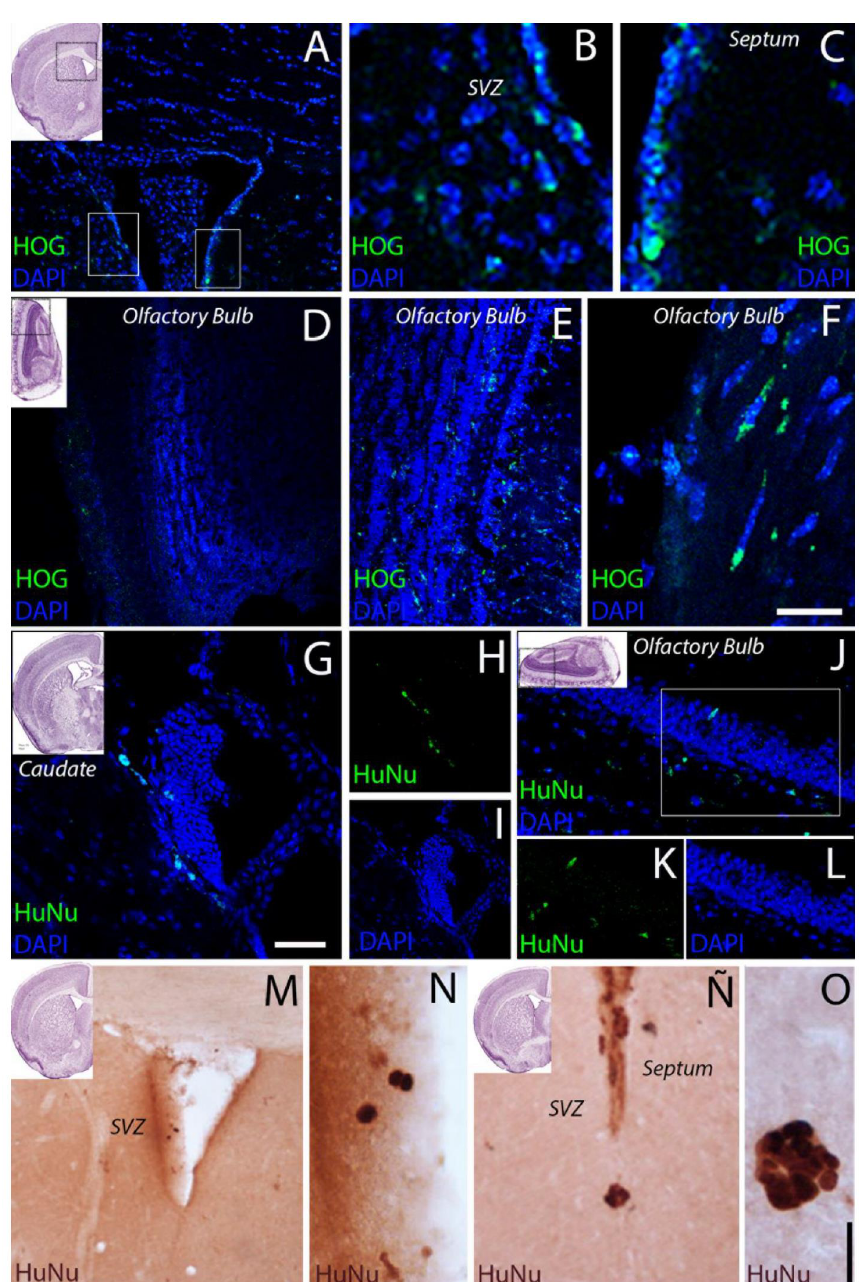
Figure 3. Representative confocal microscopy images of GFP-labelled HOG cells in different brain areas at 60 days after administration of dose 1. ( A – C ) In the periventricular region, GFP-labelled HOG cells were observed near the ventricle. ( D – F ) In the olfactory bulb, HOG cells were observed in the perigranular cell layer; these presented fusiform ( E ) or spherical morphology ( F ). Scale bar: ( A ) 200 µ m; ( B , C ) 40 µ m; ( D ) 250 µ m; ( E ): 40 µ m, ( F ): 50 µ m. HuNu-positive cells are shown in the caudate region, in the vicinity of the lateral ventricles ( G – I ) and in the olfactory bulb ( J – L ). In the ( M – O ) images, HuNu + cells are shown by IHC-DAB, observing a pattern similar to the markings of the HOG-GFP images in the ventricular region (SVZ-Septum: M – Ñ ) and grouped in small clusters ( O ). Scale bar: HOG-GFP images ( A ) 250 µ m; ( B , D ) 100 µ m; ( E , H ) 75 µ m; ( C , F ) 40 µ m. HuNu ( I , F ) images: ( G , J ) 50 µ m; ( H , I , K , L ) 100 µ m. ( D , A , B ) images: ( M ) 200 µ m; ( N ) 50 µ m; ( Ñ ) 100 µ m; ( O ) 25 µ